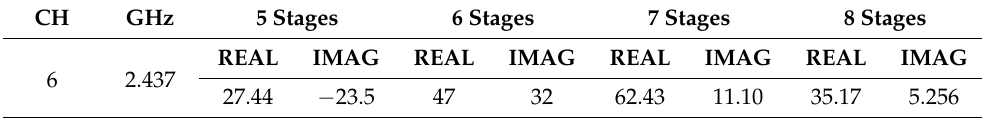
Table 3. Impedance of multipliers of 5, 6, 7, and 8 stages for Channel 6.